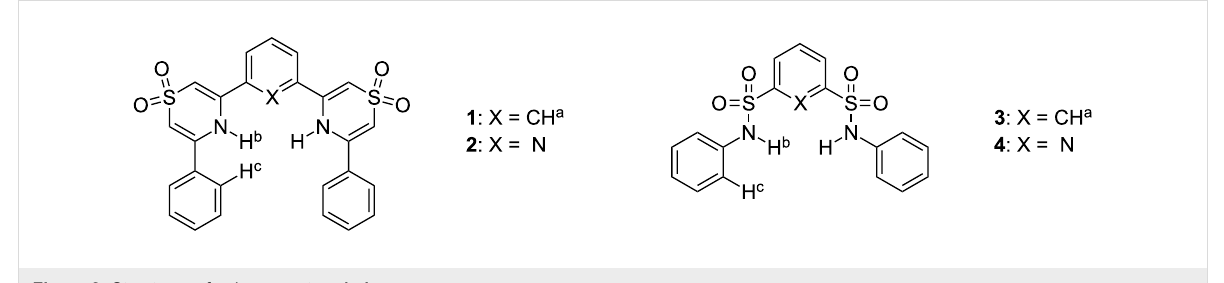
Figure 2: Structures of anion receptors 1 – 4 .